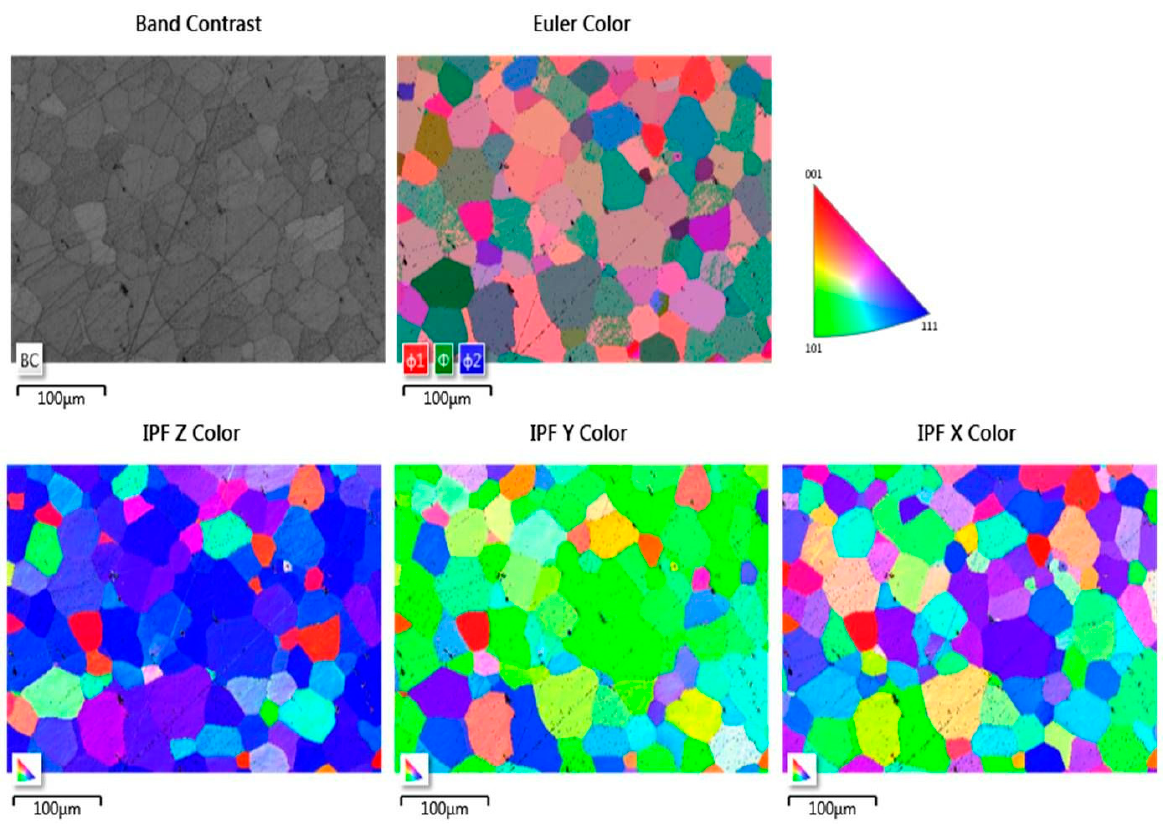
Figure 5. EBSD images of sputtered area of steel 1.4509 (AISI 441).